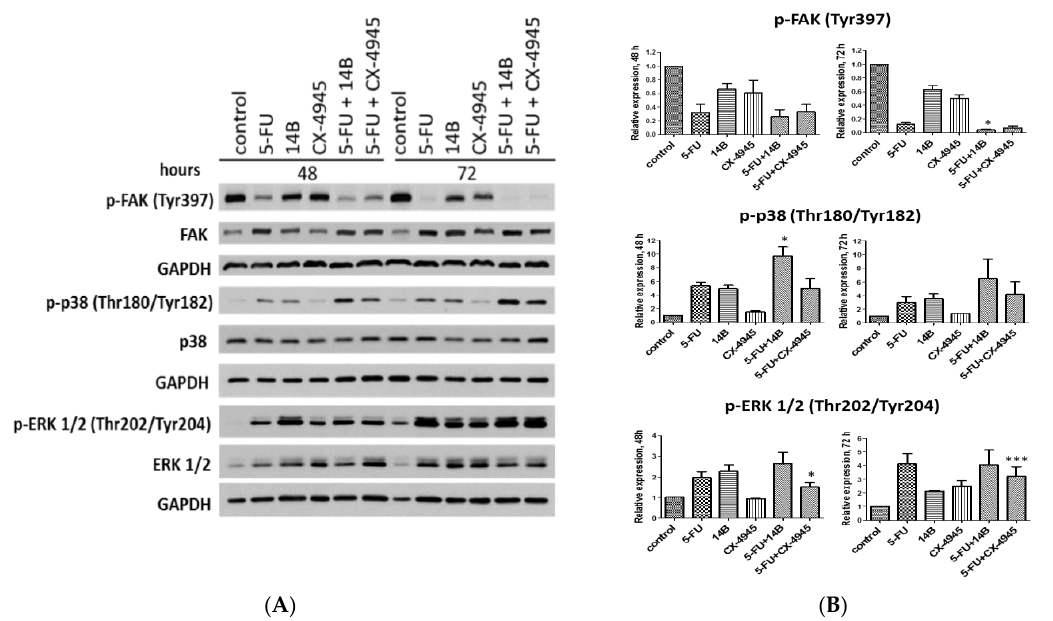
Figure 3. Western blot analysis of FAK, p38, and ERK1 / 2 kinases in crude extracts obtained from MDA-MB-231 after 48 h and 72 h treatments with 15 µ M 5-FU, 2 µ M 14B, and 5 µ M CX-4945 used separately or in combination. GAPDH was used as a loading control for each sample: ( A ) The representative blots; ( B ) densitometry quantifications for phosphorylated proteins are shown in the graphs, with untreated cells serving as the reference point (1). Statistically, significantly different from that of 5-FU-treated cells and the drug combinations by student’s t -test were indicated in figures by asterisks as follows: * p ≤ 0.05, ** p ≤ 0.01, and *** p ≤ 0.001. (see Materials and Methods).